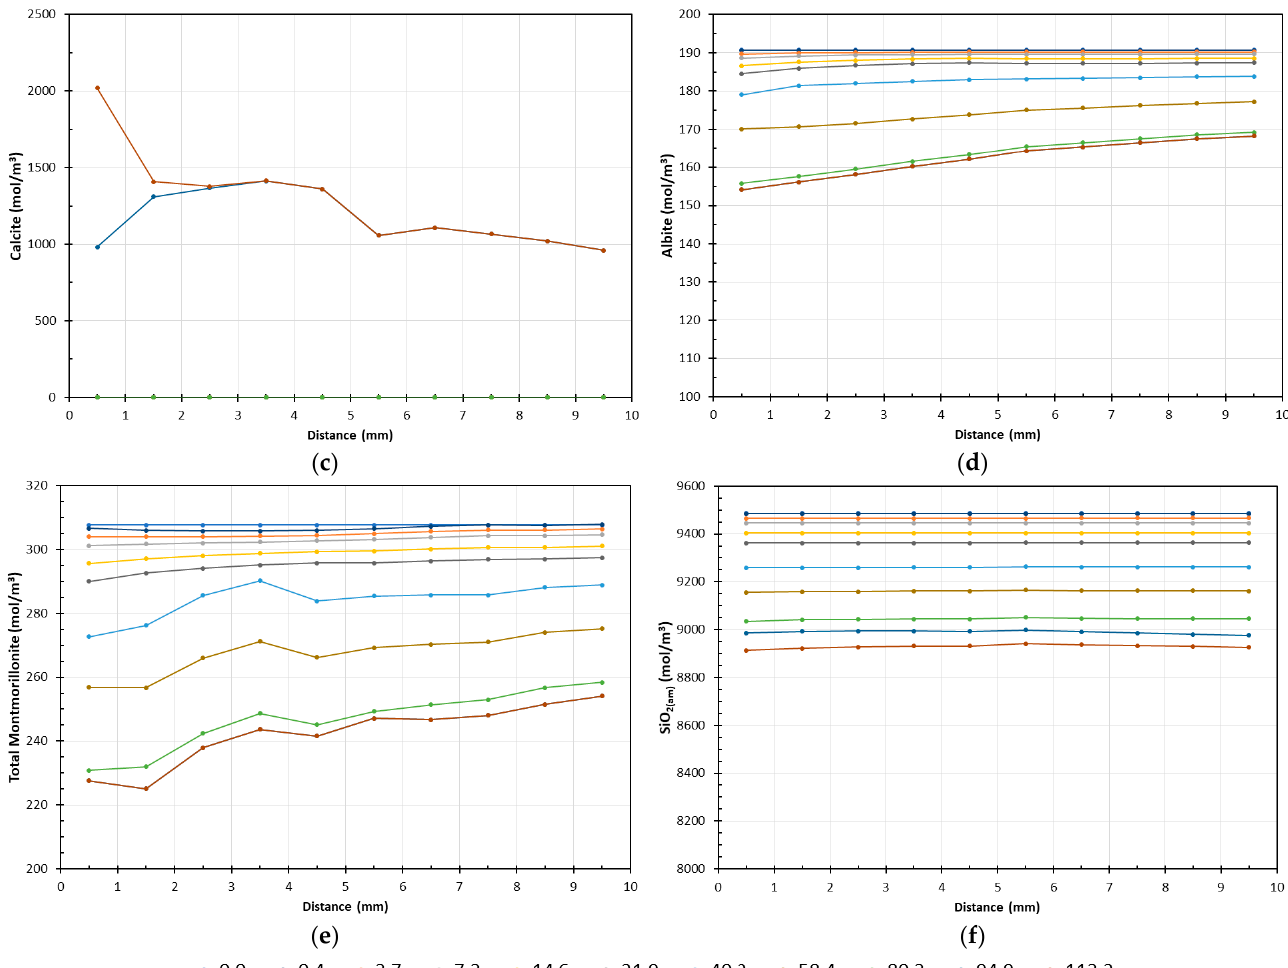
Figure 10. Legend for all plots, except porosity; ( a ) time step (days), selected model data showing variation along the length of SFC with time; ( a ) porosity, red dashed line indicates initial porosity; ( b ) total C-S-H present; ( c ) calcite; ( d ) albite (as representative of the feldspars); ( e ) total montmorillonite; and ( f ) amorphous silica. Time step of 40.2, ( d ) change from ‘young’ to ‘evolved’ OPC leachate; time step of 80.3, ( d ) change from “evolved’ OPC leachate to